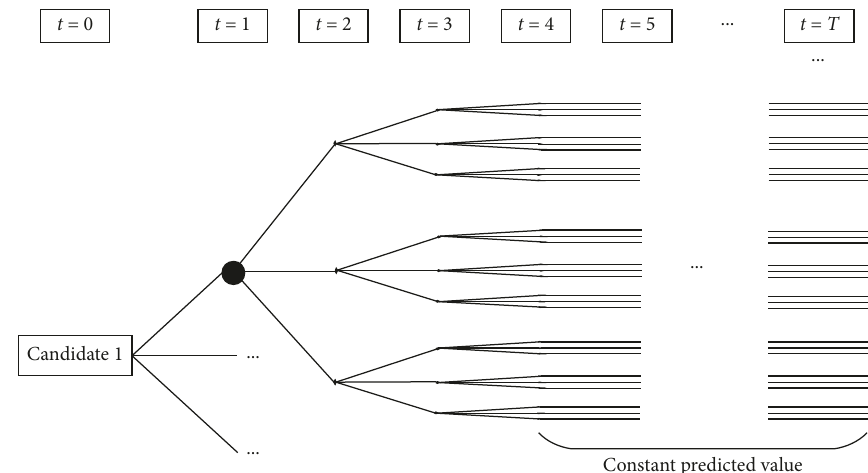
Figure 3: Simplified multistage scenario tree (random inflows of candidate 1).